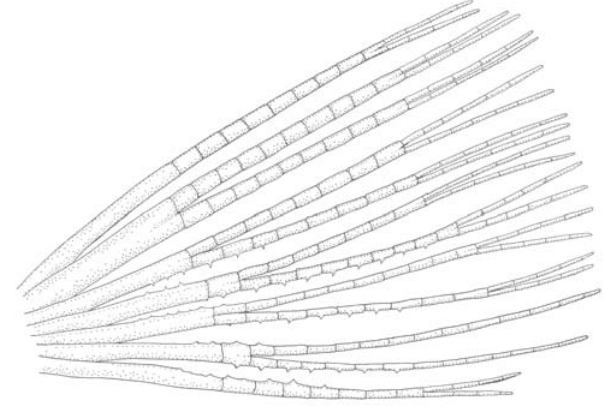
right.Fig. Fig. 47. Mimagoniates pulcher , developing male, MNRJ 4233, 34.2 mm SL; osteology of principal caudal rays 7-15, lateral view, left side, anterior at Fig. 48. Mimagoniates pulcher , male, MNRJ 4233, 43.2 mm SL; caudal-fin squamation of dorsal and ventral portions of caudal- fin